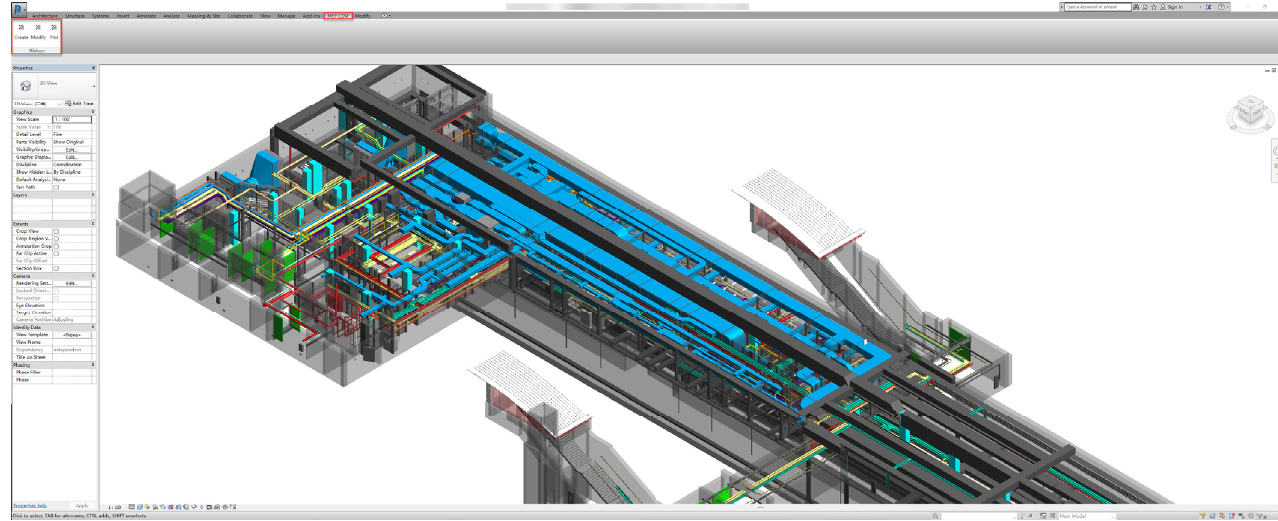
Figure 11. The BIM model and the CDM tab.